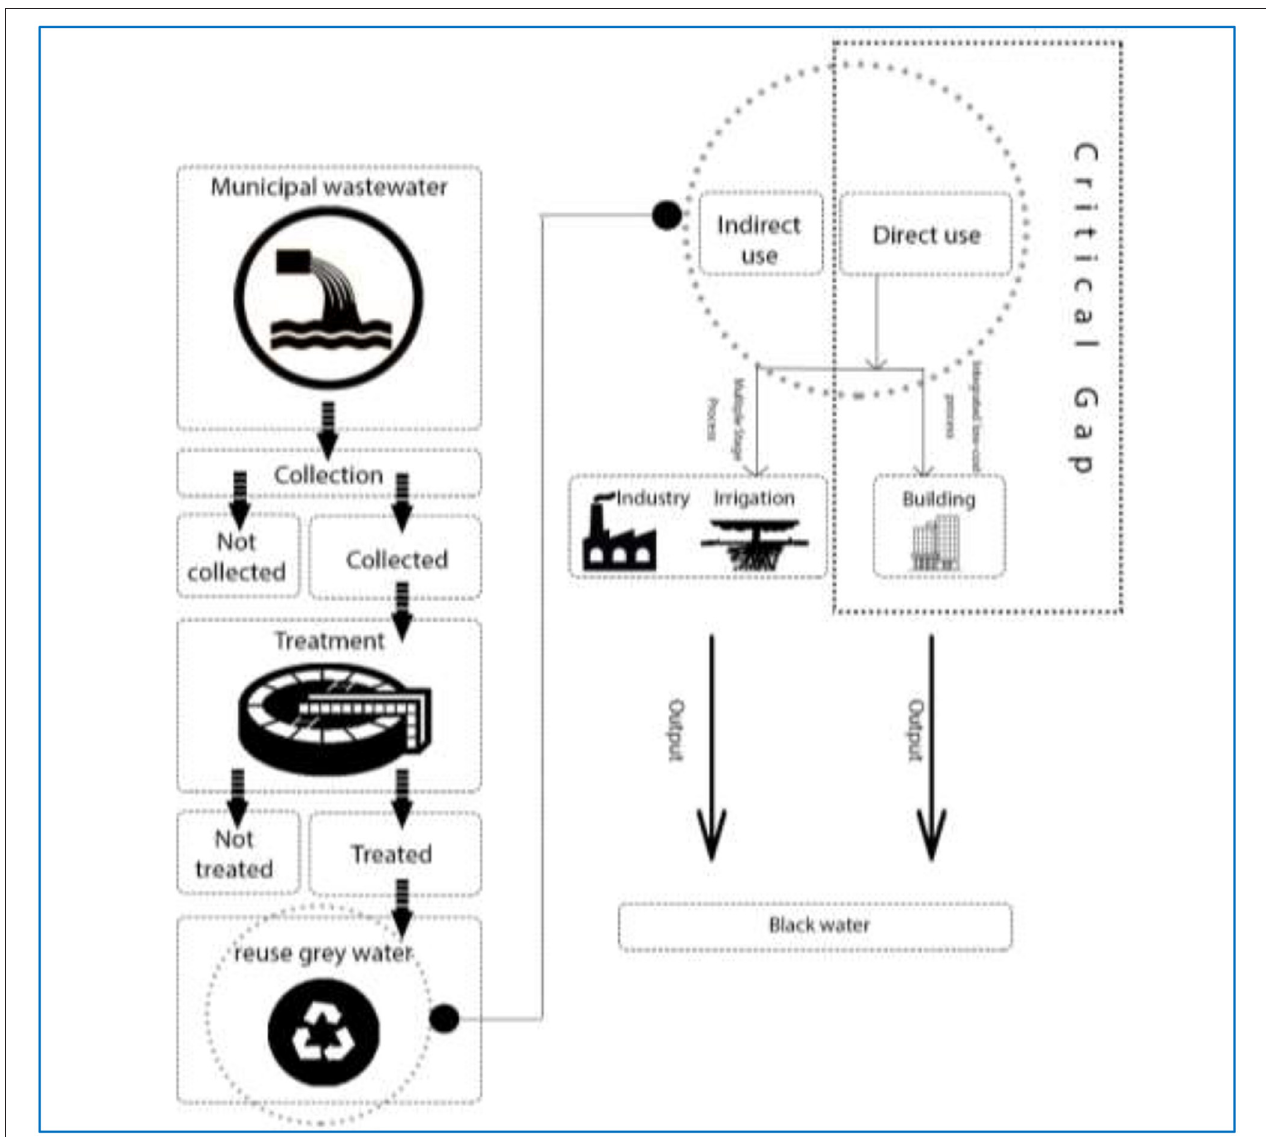
FIGURE 1 | The process of municipal wastewater production to reuse [adapted from AQUASTAT